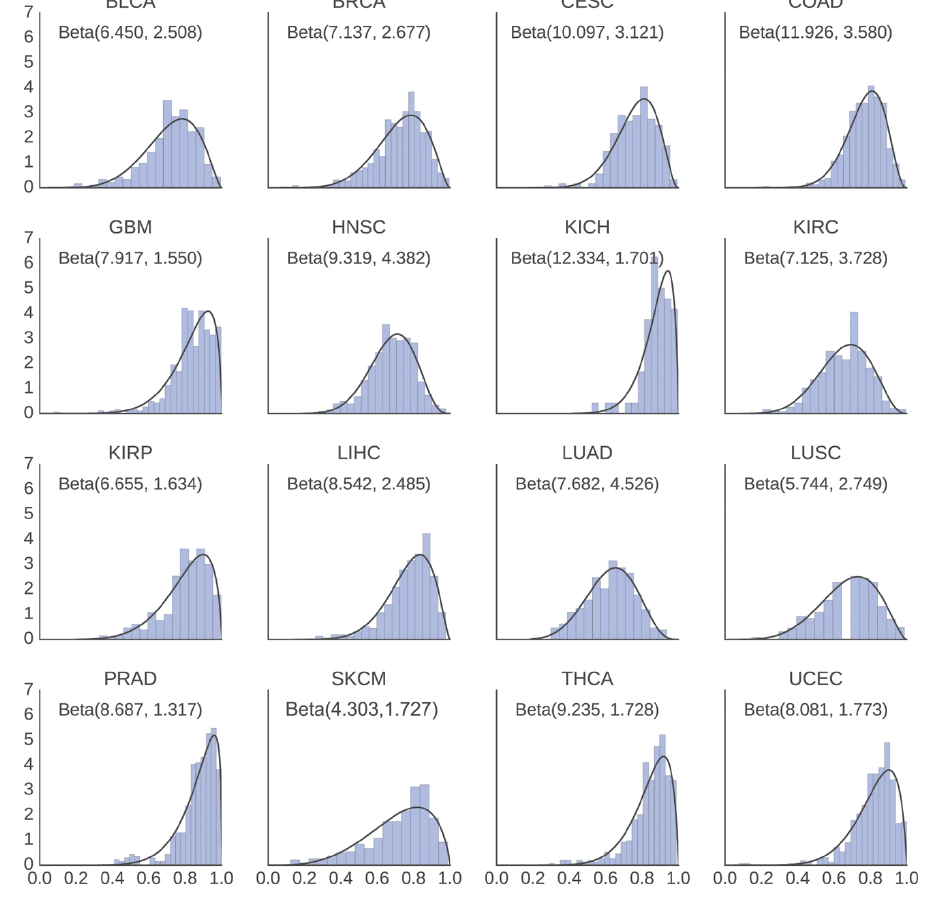
Figure 2: Distribution of estimated purities and the fitted beta distributions. Estimated shape parameters are shown as Beta ( β , β ). We observe that a beta distribution is a good fit for the tumor purity 1 k 2 k